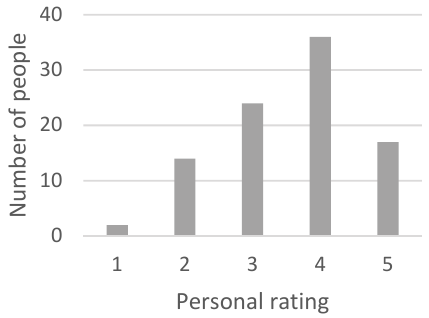
Figure A17. Perceived personal waste sorting behavior, second survey (93 individuals).